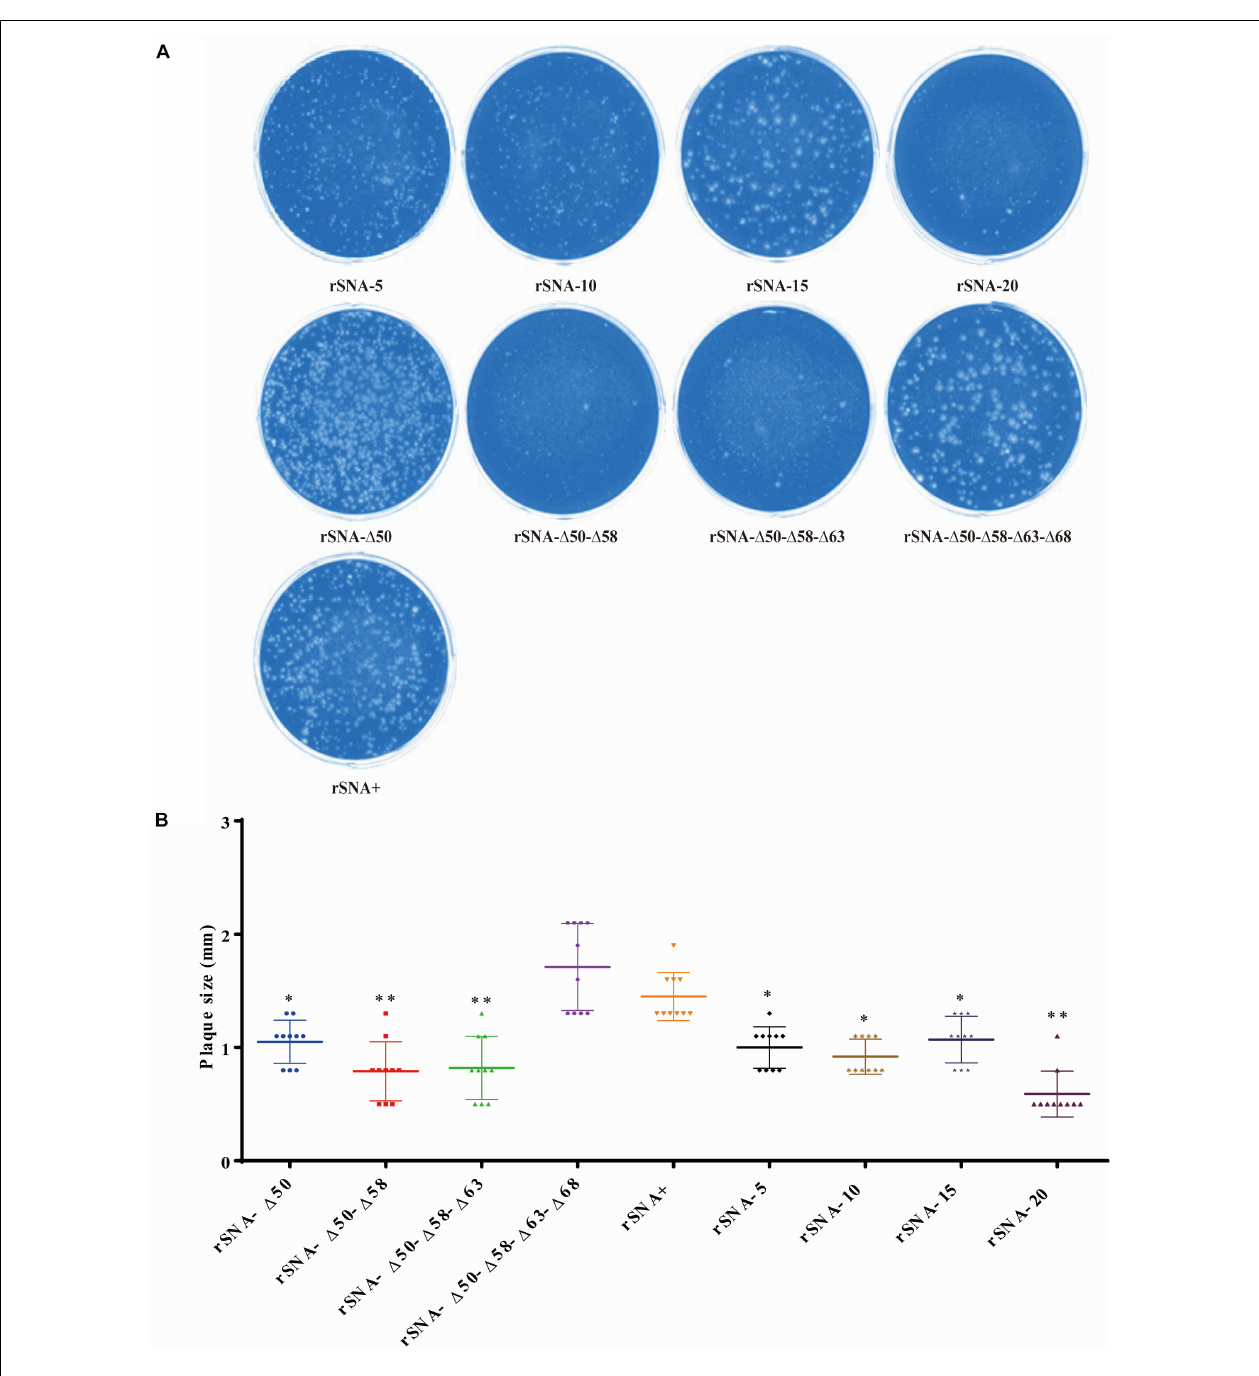
FIGURE 3 | Plaque assay in MDCK cells of recombinant viruses (A) . The diameter of 10 independent plaques was measured for each virus sample (B) . * P < 0.05, ** P < 0.01, compared to the value of the rSNA+.